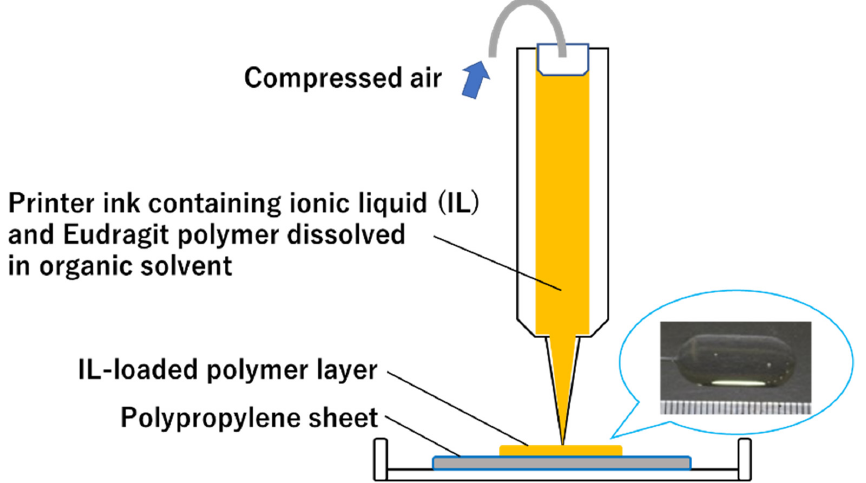
Figure 1. Concept underlying the 3D printing of oral films.